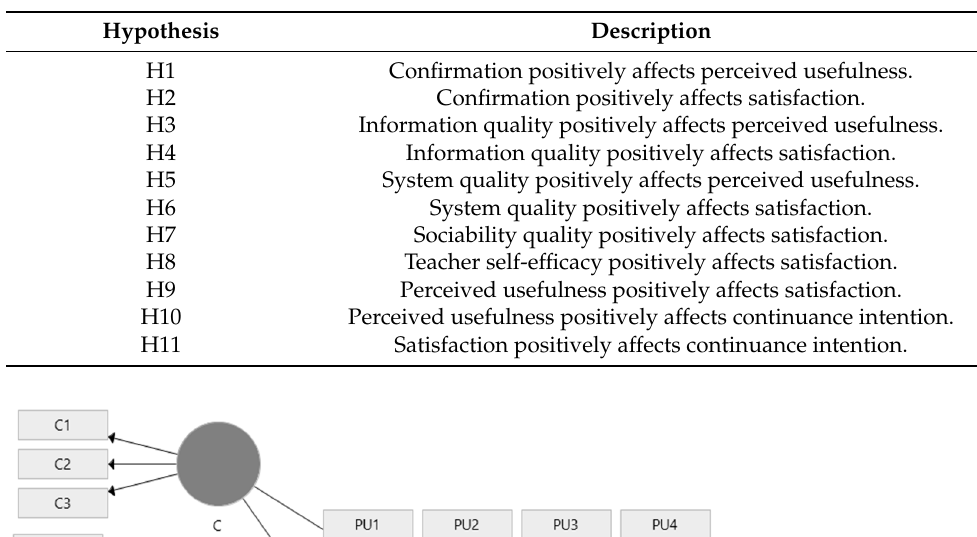
Table 1. Eleven Research Hypotheses for Continuance Intention of E-learning.